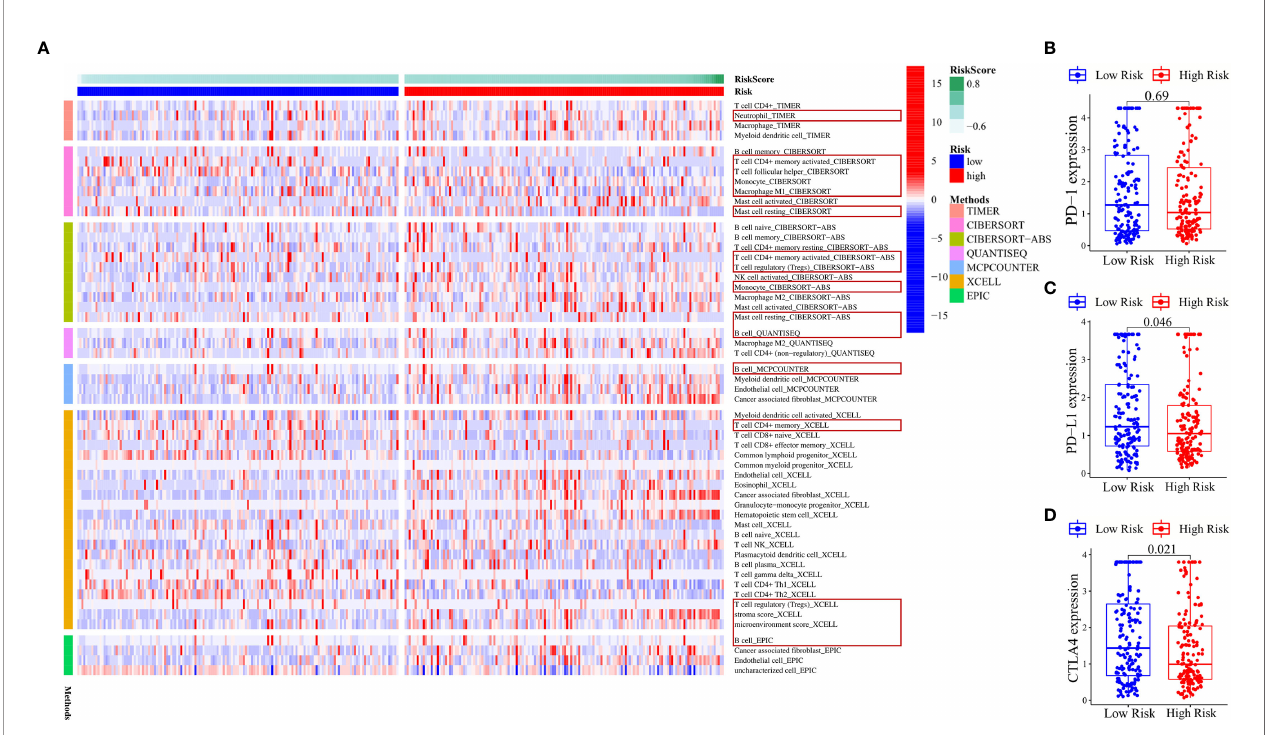
FIGURE 7 | Various algorithms veri fi ed the results of immune cell in fi ltration and the expression of immune checkpoints in the ferroptosis-related ncRNA signature. (A) Heat map showing the expression difference of each immune cell based on different algorithms in the high- and low-risk groups. The red box indicates that these immune cells can verify the above-mentioned conclusions. (B – D) Differences in the expression of PD-1, PD-L1, and CTLA4 between high- and low-risk groups. The values in the fi gure are P